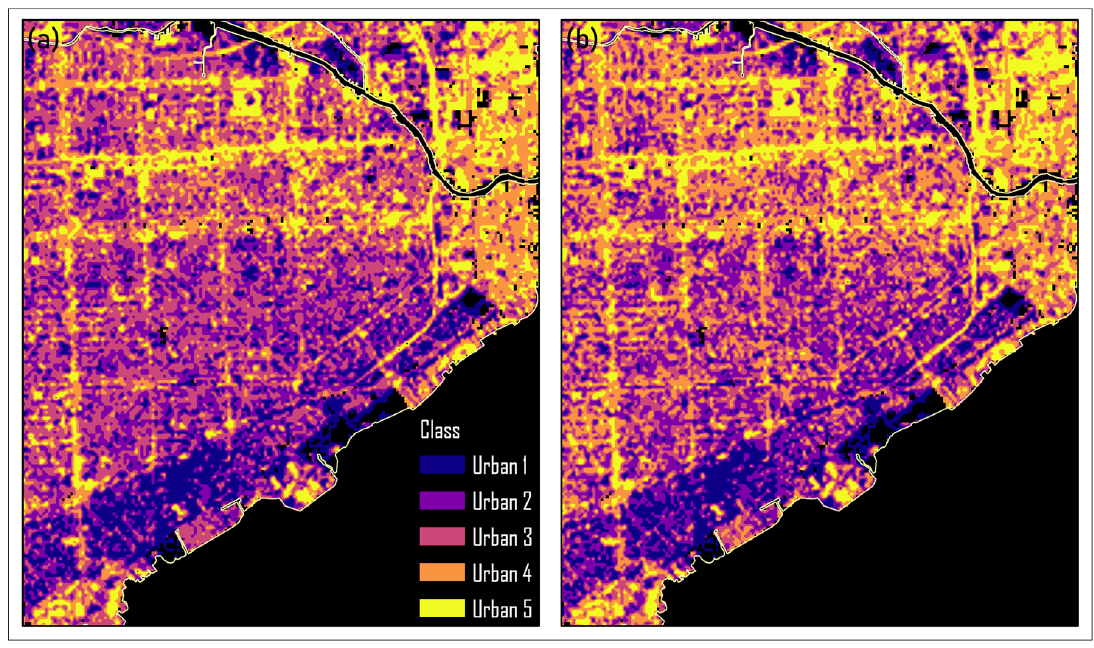
Figure 9. Iso cluster classifications of urban land use intensity based on spectral index composites derived from 22 October 2016 Landsat 8 OLI data; ( a ) NDCCI / NBI / BAEI composite, ( b ) NDVI / NBI / BAEI composite.